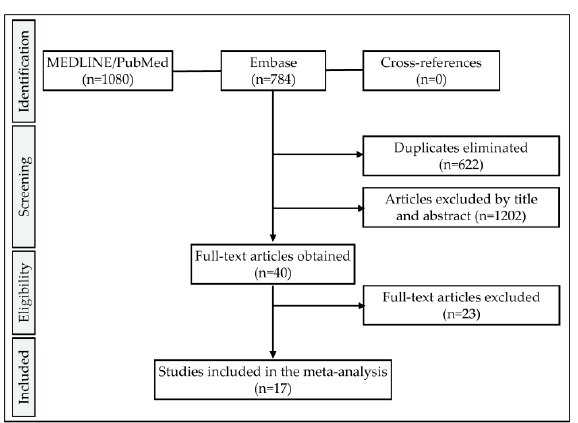
Figure 1. Flowchart according to the preferred reporting items for systematic reviews and meta-analyses (PRISMA) guidelines.